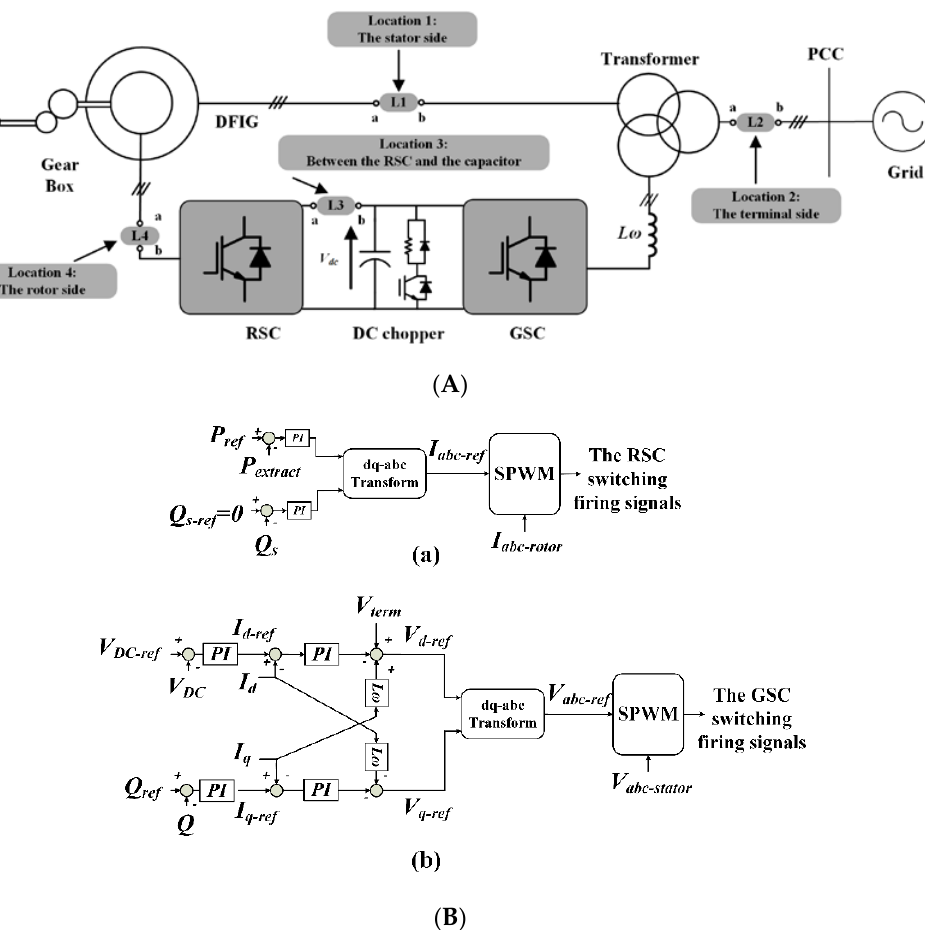
Figure 3. ( A ) The doubly-fed induction generator (DFIG) configuration, with all possible highlighted locations for the fault current limiters and series dynamic braking resistors, in the fault ride-through capability improvement. RSC: Rotor side converter; GSC: Grid side converter; PCC: Point of the common coupling. ( B ) The schematic of control circuits for: ( a ) The rotor side converter; and ( b ) the grid side converter [15]. Adapted with permission from [15], Copyright Publisher, 2017.